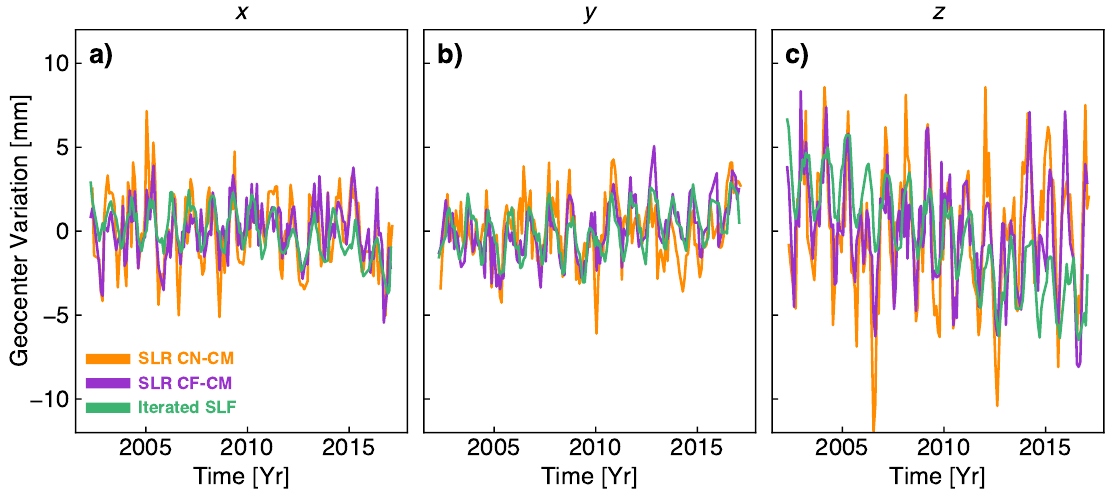
Figure 8. Time series of measured and recovered geocenter variations, ( a ) x , ( b ) y and ( c ) z , in mm from satellite laser ranging (orange and purple) and time-variable gravity fields provided by the Center for Space Research (green). The SLR-derived solutions in orange (CN-CM) are the traditional solutions that center the SLR network [15], and the SLR-derived solutions in purple (CF-CM) include the effects of local site displacements [5]. The solutions derived from GRACE/GRACE-FO in green use an iterated self-consistent geocenter that takes into account the effects of self-attraction and